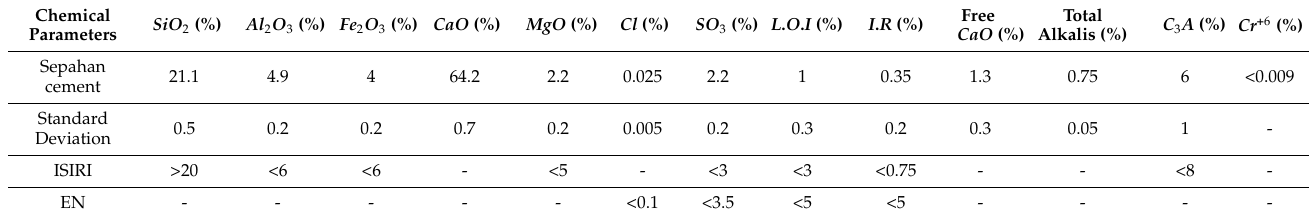
Table 5. Chemical properties of Portland cement (Type